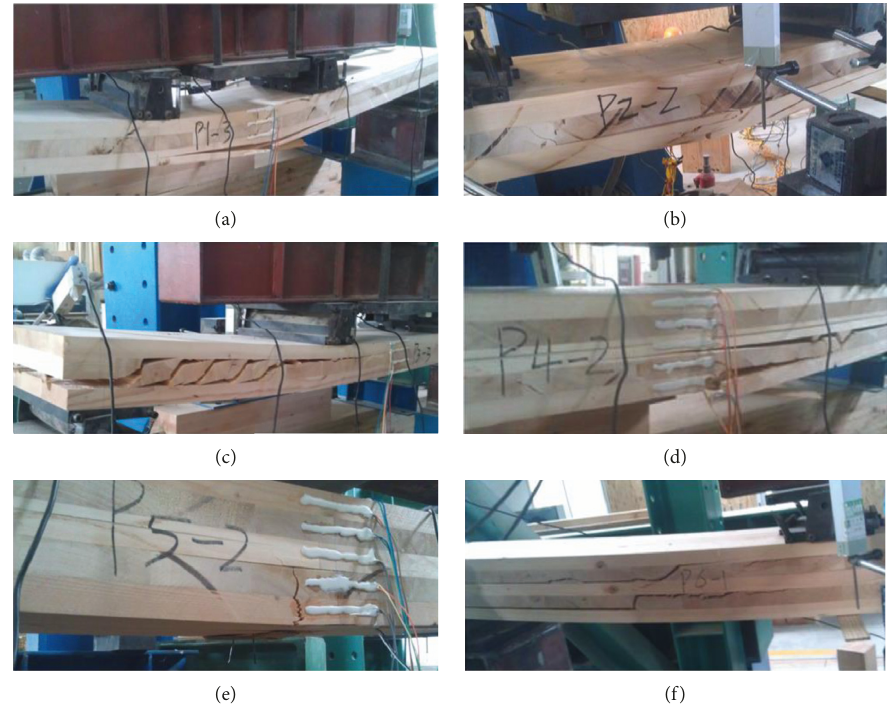
Figure 2: Typical failure modes of P1–P6. (a) Specimen P1. (b) Specimen P2. (c) Specimen P3. (d) Specimen P4. (e) Specimen P5. (f) Specimen